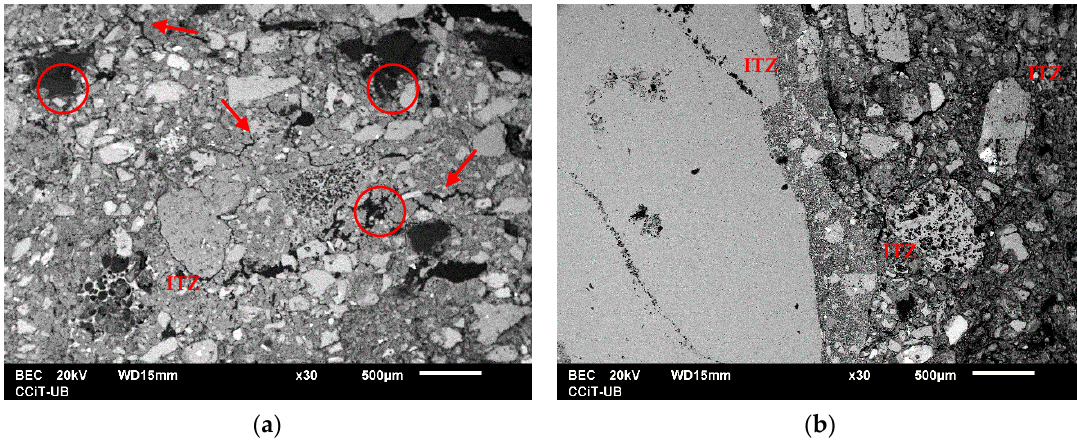
Figure 10. SEM of study samples ( a ) Variable of study-sand from Only Concrete-Mucilage (V-OC-M); ( b ) Variable of study-sand from All in One-Mucilage (V-AiO-M).